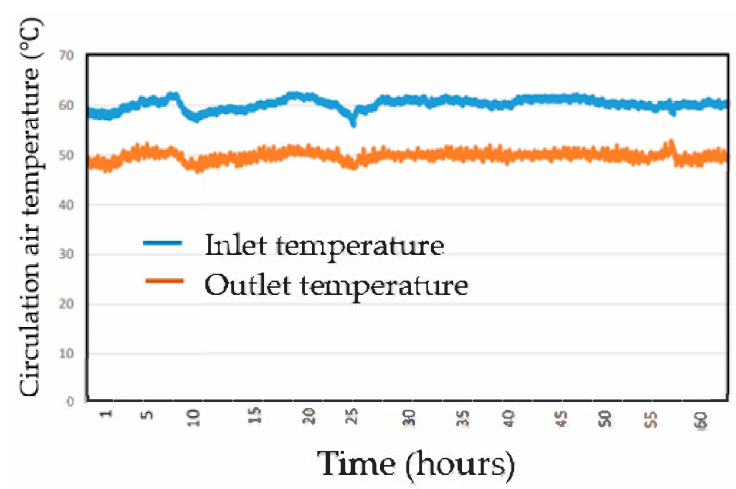
Figure 11. Measurement circulating air temperature di ff erence between the inlet and outlet of the chamber connected to the third heat pump with the auxiliary subsystem.